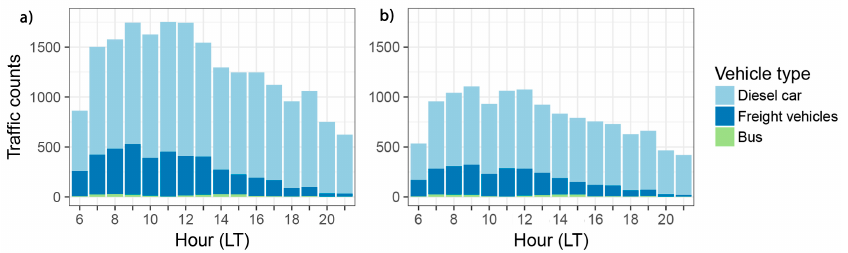
Figure 3. Distribution of traffic flow for diesel vehicles at measuring points: ( a ) intersection K4 and ( b ) site B.